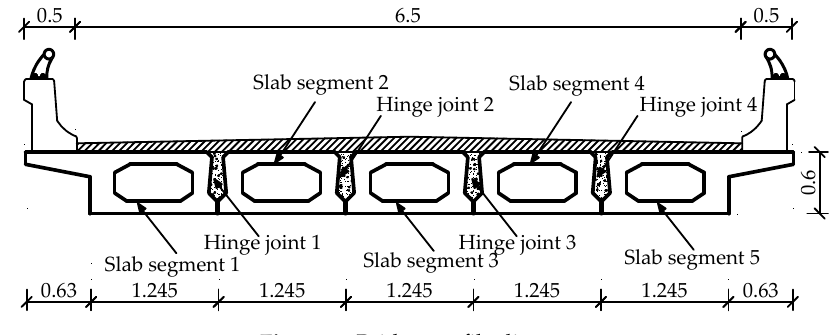
Figure 2. Bridge profile diagram.